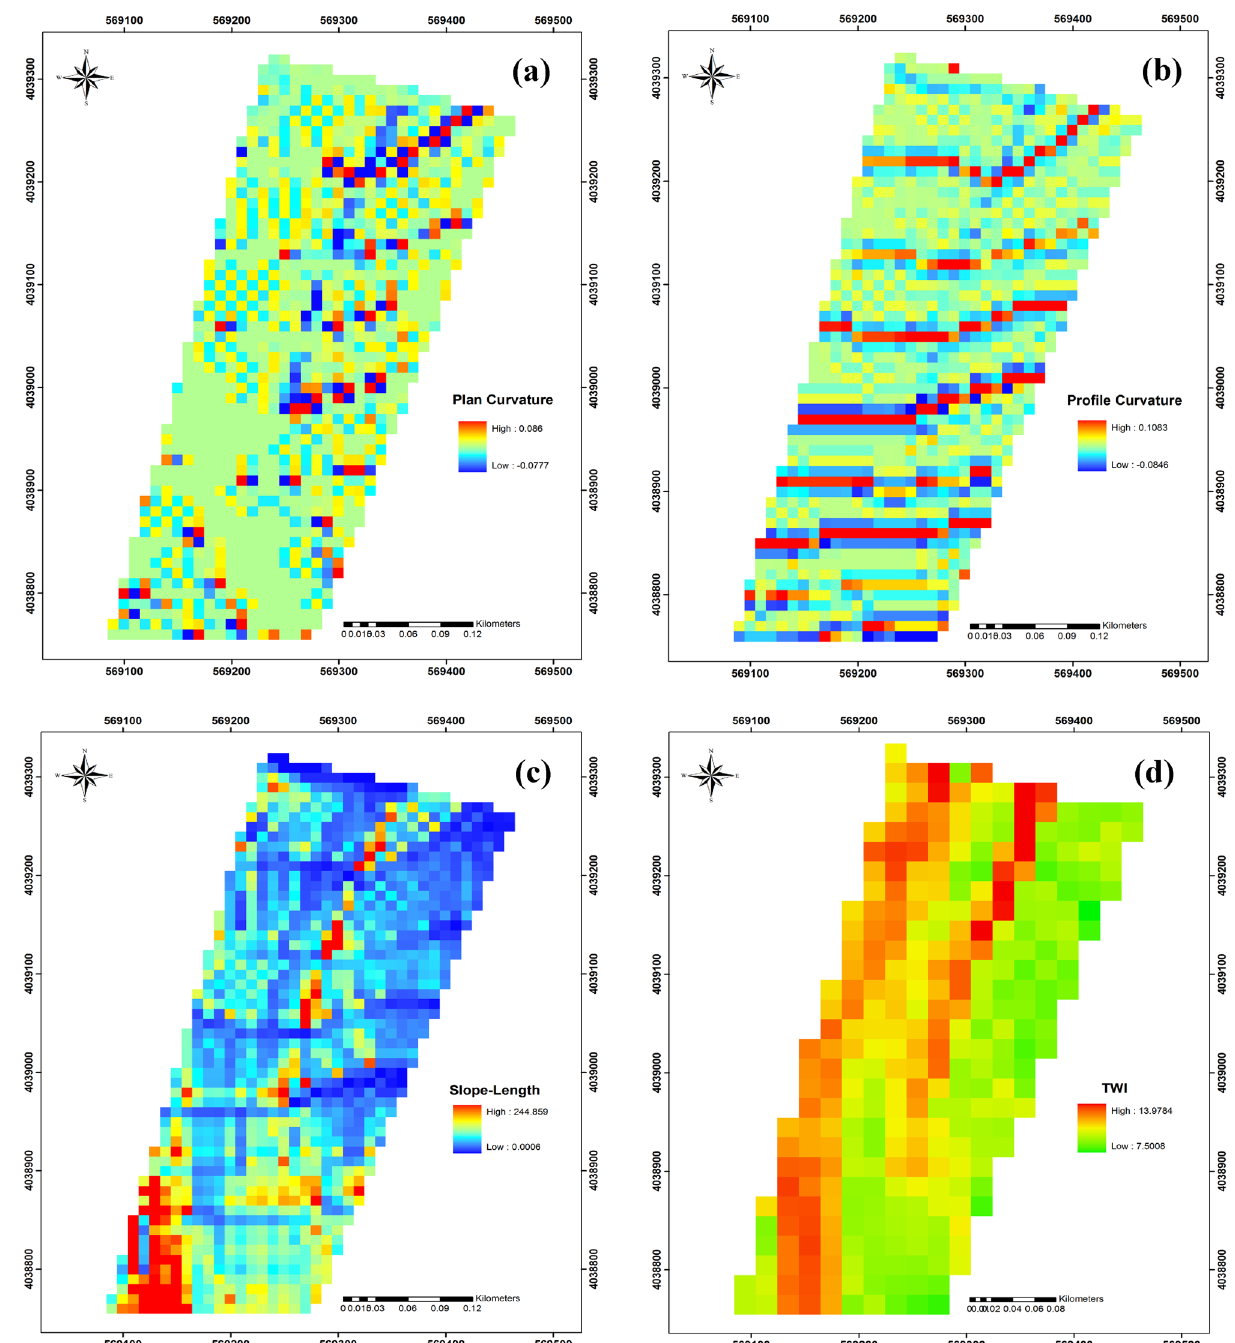
Figure 3. Plan curvature map of the study area ( a ), the profile curvature map of the study area ( b ), the slope length of the study area ( c ), topographic wetness index for the study area ( d ). The locations of all six catenas are clearly visible in the profile curvature map, somewhat visible in the slope length map, and partially visible in the plan curvature map. This calculation of the topographic wetness index appears not to be affected by the catena